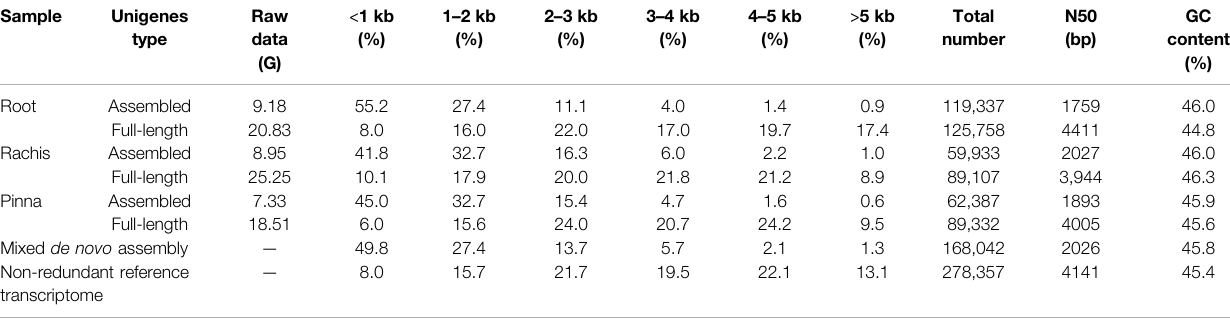
TABLE 1 | Statistics for the assembled and the full-length transcriptomes Sample